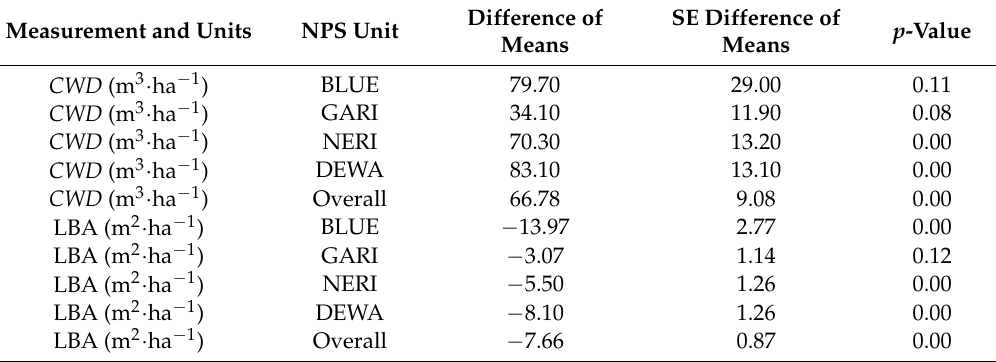
Table A5. Tukey method comparison for differences of means (disturbed–undisturbed) for change in coarse woody debris (CWD) (m 3 · ha − 1 ) and live basal area (LBA) (m 2 · ha − 1 ) between disturbed and undisturbed plots for each NPS unit and for all the units combined following the disturbance events.